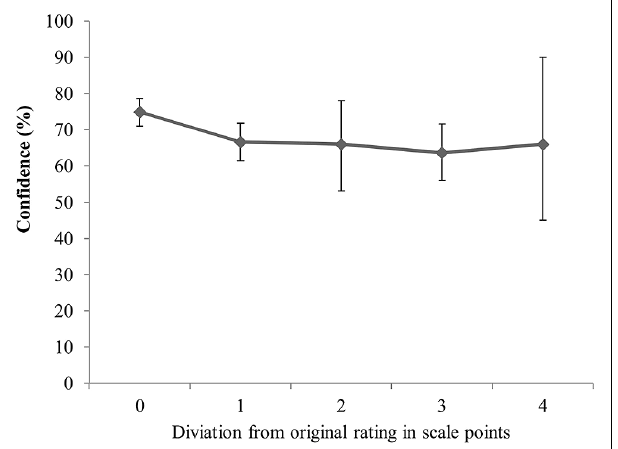
FIGURE 5 | Confidence as a function of the deviation from the original sympathy rating for detected and non-detected trials. Error bars represent 95% confidence